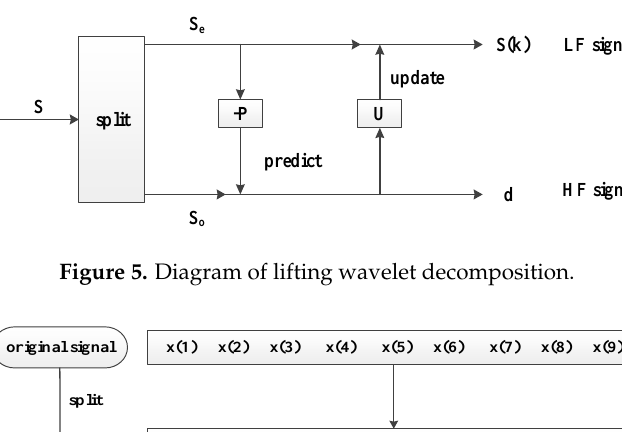
Figure 6. Rendering of lifting wavelet decomposition.